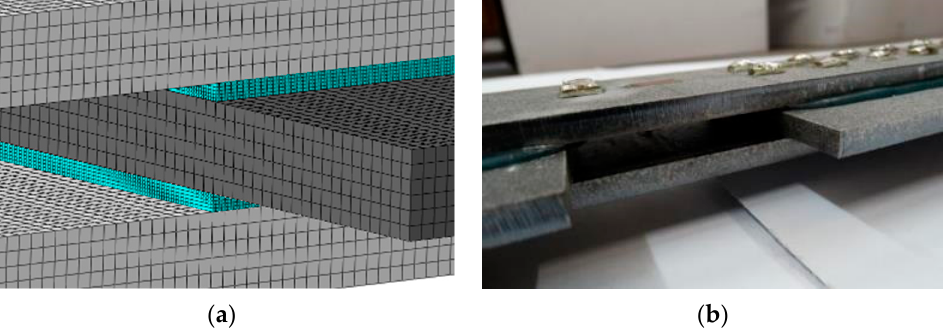
Figure 15. View of the joint in the middle of the specimen: ( a ) numerical model; ( b ) laboratory test.